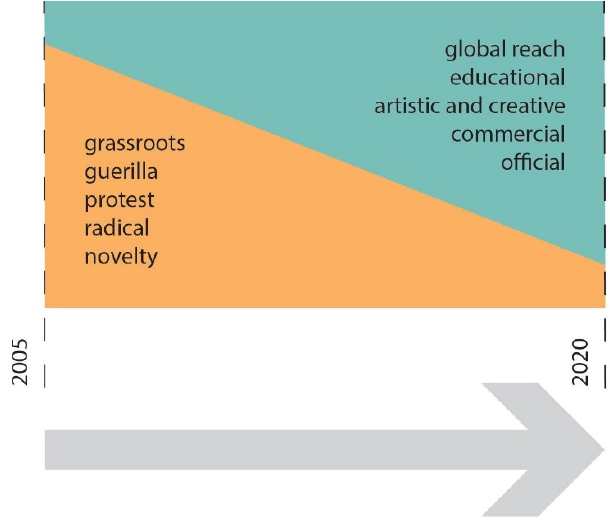
Figure 5. General trajectory of PD evolution to the present day.